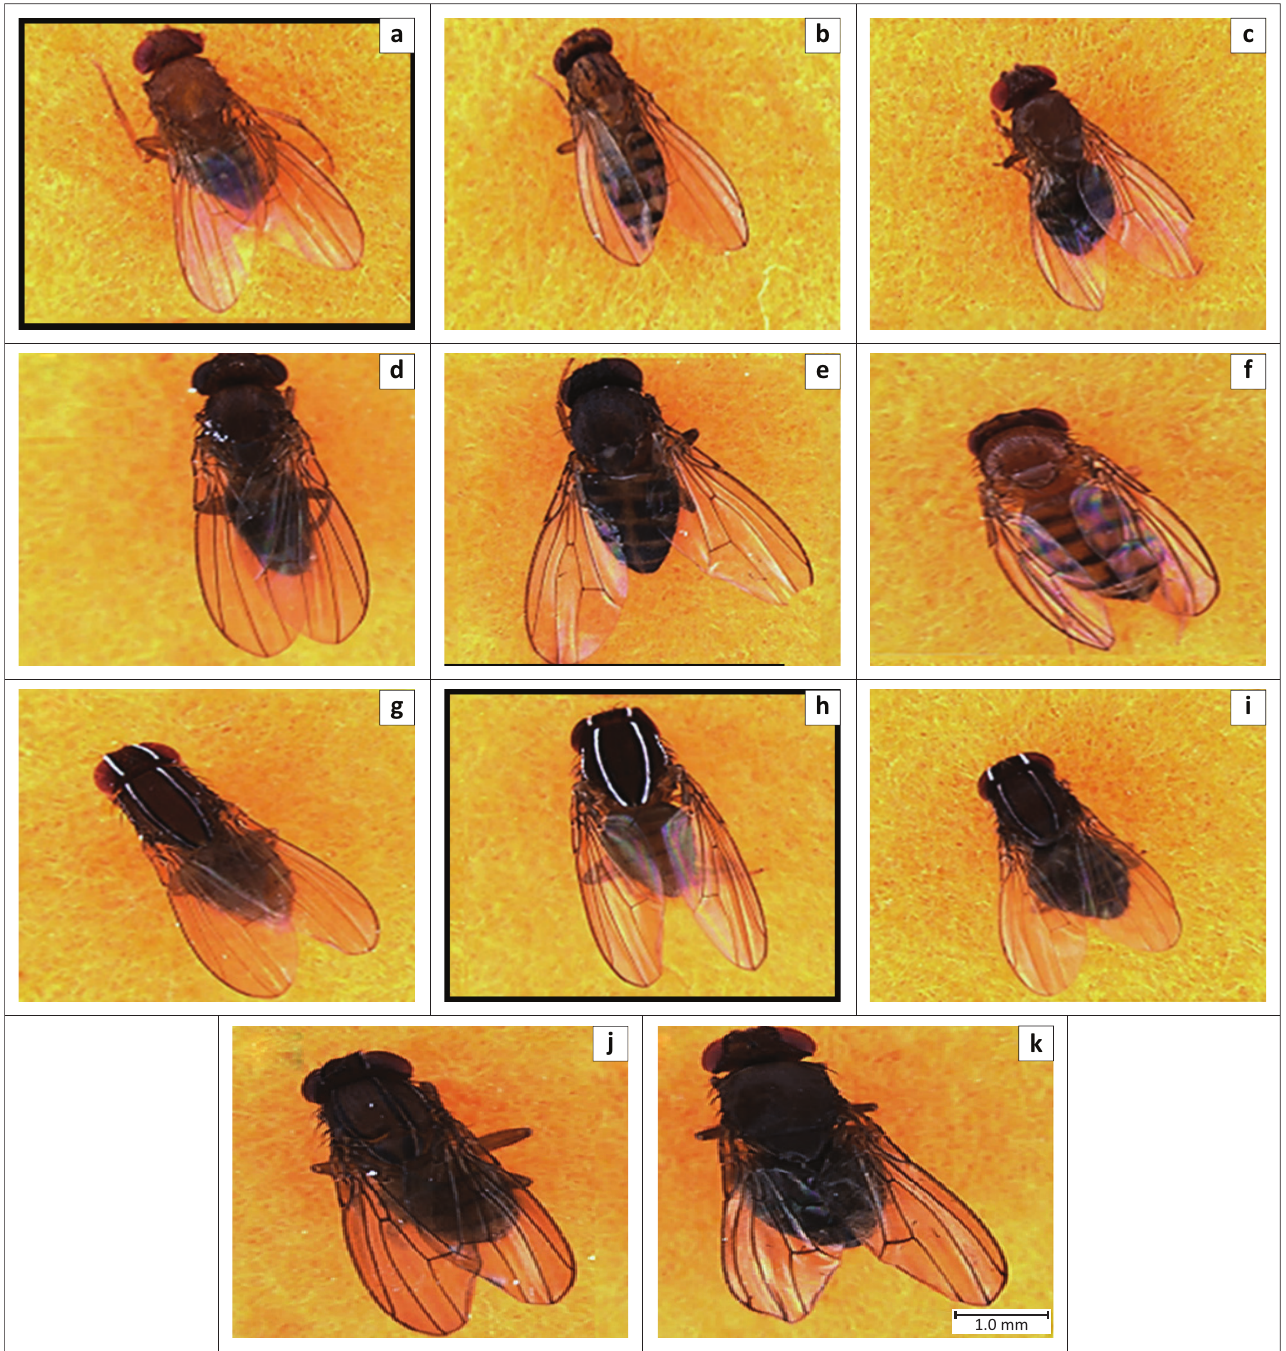
FIGURE 2: Eleven of the 13 Drosophilidae species sampled across South Africa. (a) Drosophila ananassae , female; (b) D. busckii , female; (c) D. melanogaster , female; (d) D. funebris , male; (e) D. hydei , male; (f) D. simulans , female; (g) Zaprionus indianus , female; (h) Z. taronus , male; (i) Z. tuberculatus , male; (j) Z. vittiger , male; and (k) D. immigrans, female . Note all species are represented at a shared scale of 1 mm. Black boxes indicate the species that are new records for South Africa; there is no image available for D. nasuta and D. yakuba